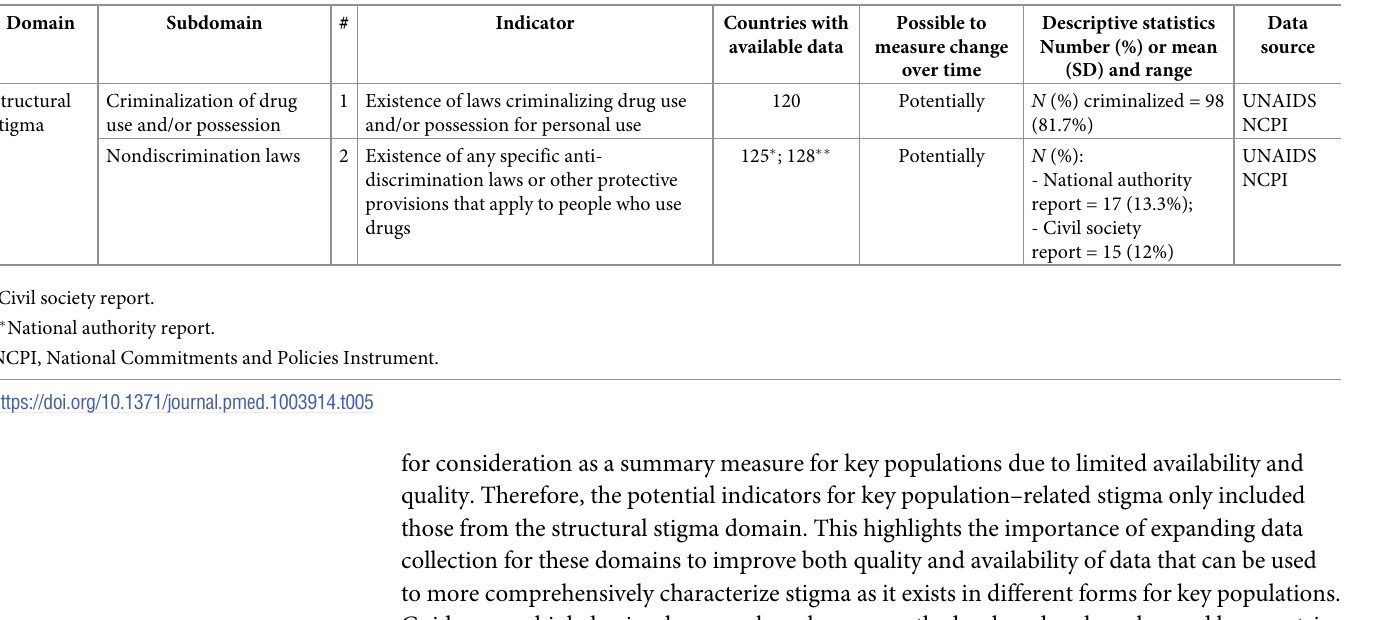
Table 5. Final indicators for drug use stigma.